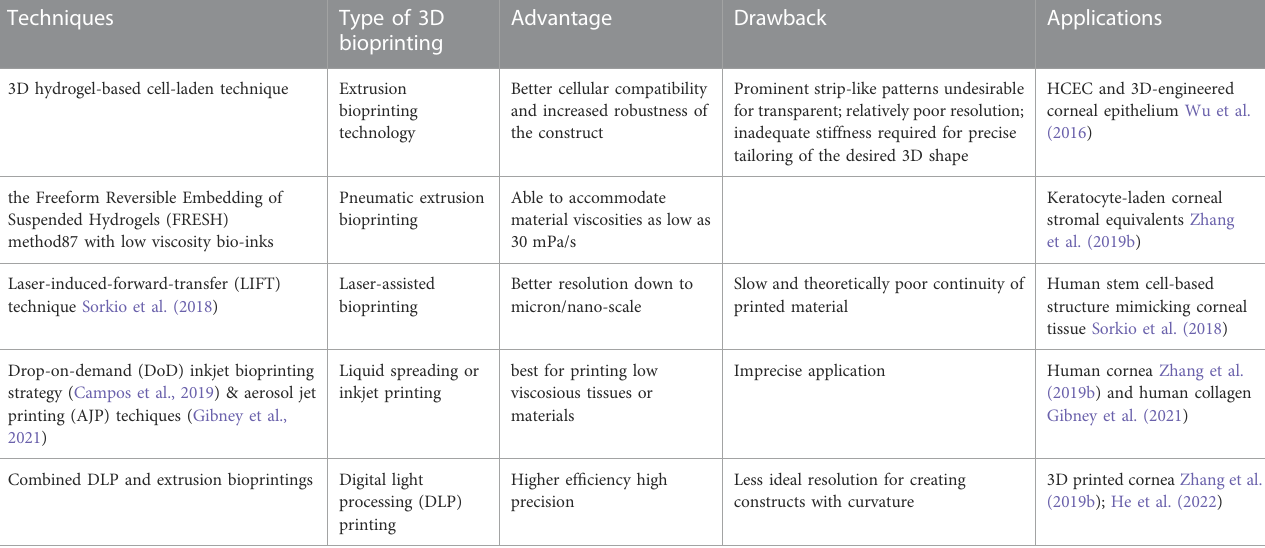
TABLE 2 Summary of different types of 3D printing technology and their applications.